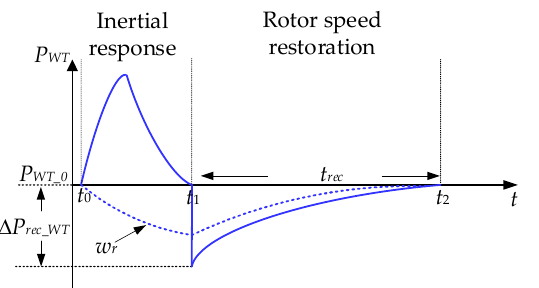
Figure 4. Active power and rotor speed change of DFIG during the frequency response stage.